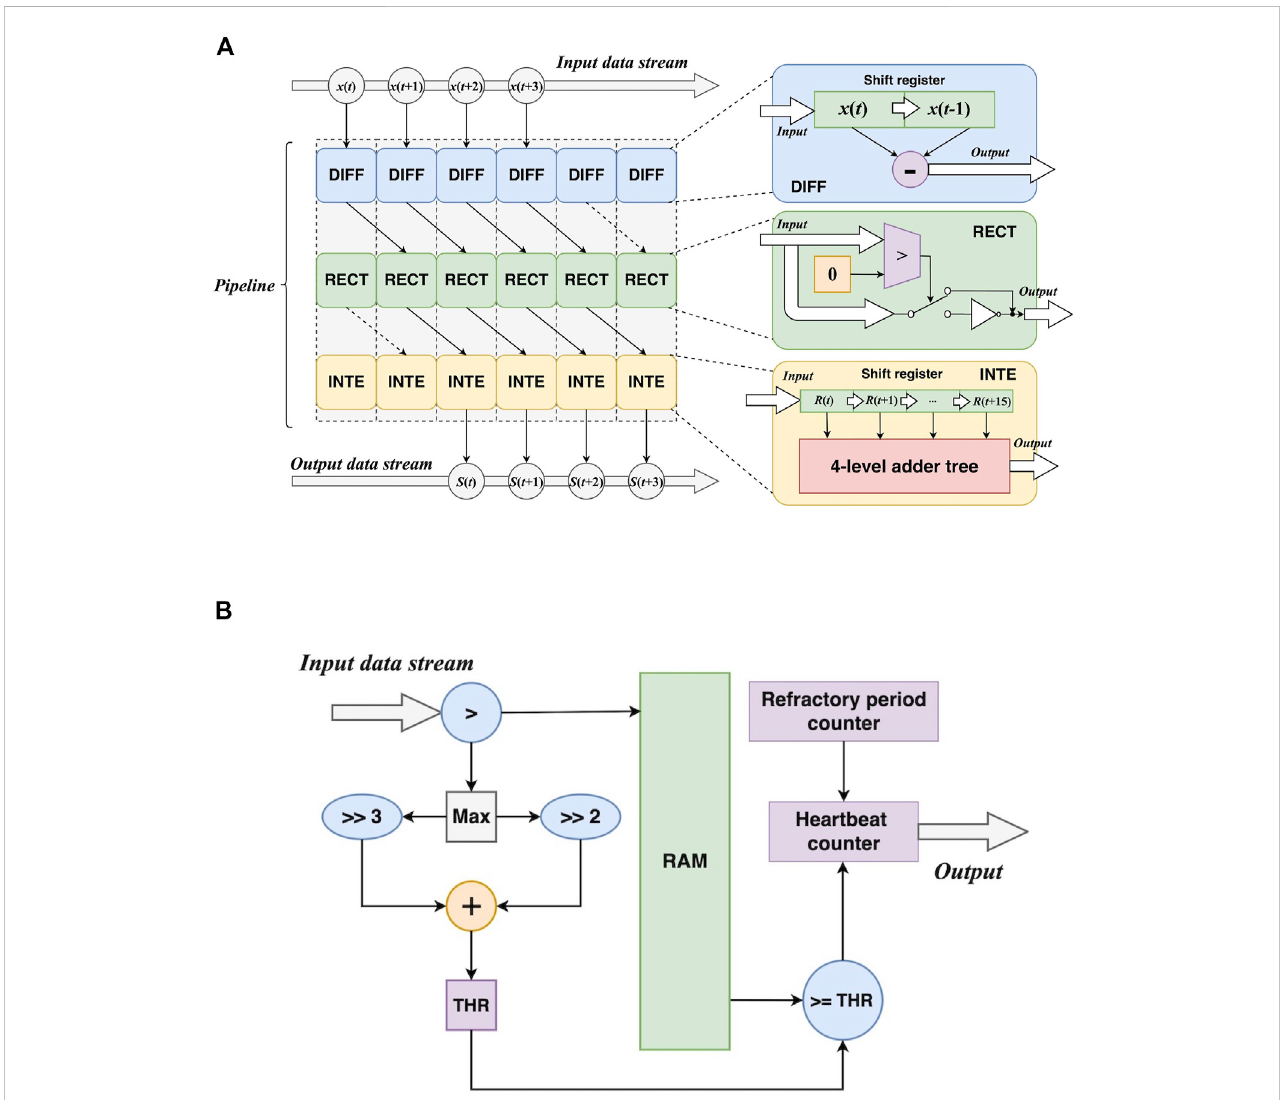
FIGURE 7 Hardware design of the preparation before heart rate calculation. (A) The pipelined design of the transformations DIFF: differentiation; RECT: recti fi cation; INTE: integration. (B) The design of self-adaptive threshold calculation.